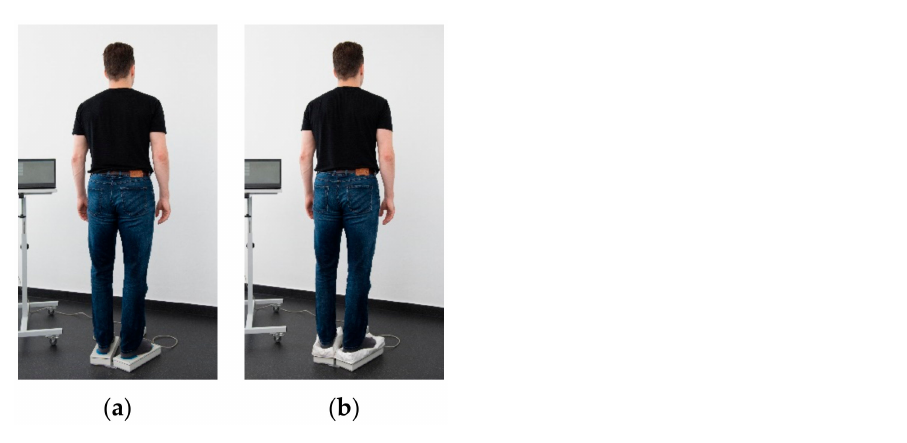
Figure 1. ( a ) Subject on stable force plates, ( b ) subject on force plates with foam pads. Source: Andreas Lauenroth (person is one of the